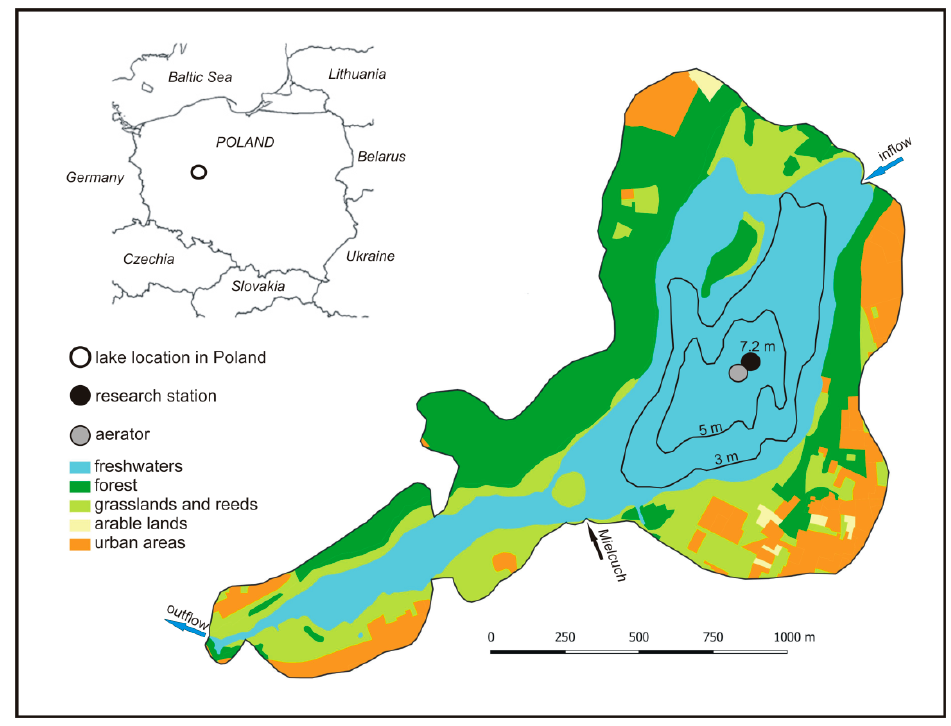
Figure 1. Land use of the direct catchment area of Swarz ę dzkie Lake and bathymetric map and location of sampling station (after [31], modified).